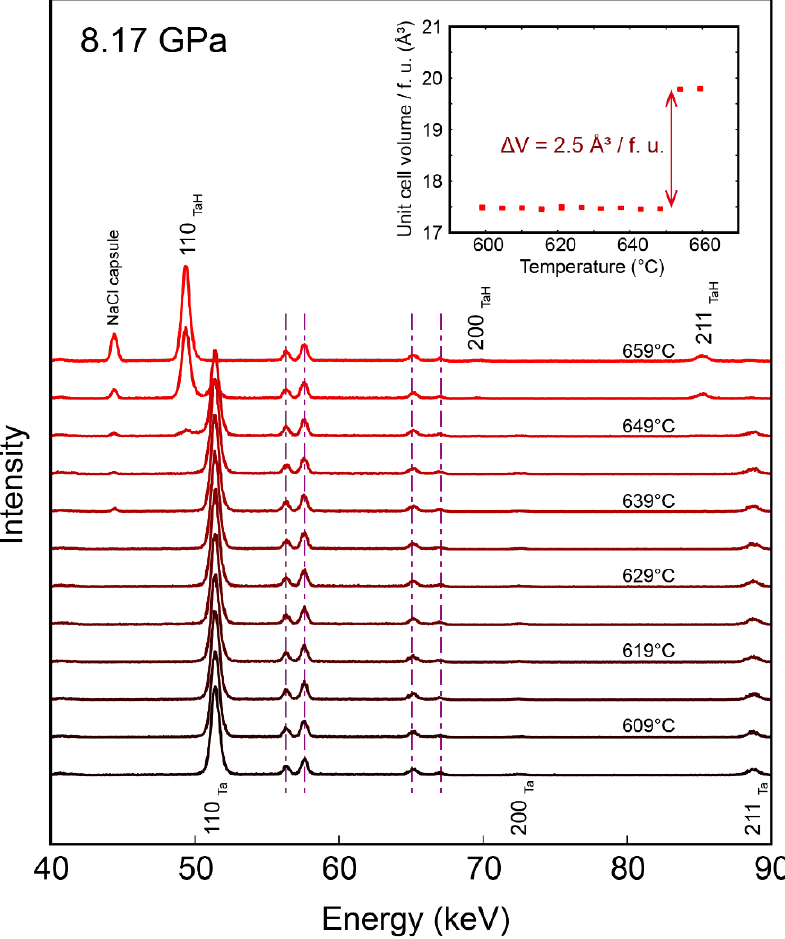
Figure 1. Series of in situ synchrotron radiation powder X-ray diffraction patterns of Ta and BN powder mixture at 8.17 GPa during heating from 599 °C to 659 °C. Discontinuous lattice expansion was observed at 642 °C and was caused by the hydrogenation reaction of bcc Ta to form distorted bcc TaH. The peaks on the dashed lines correspond to fluorescence from Ta.